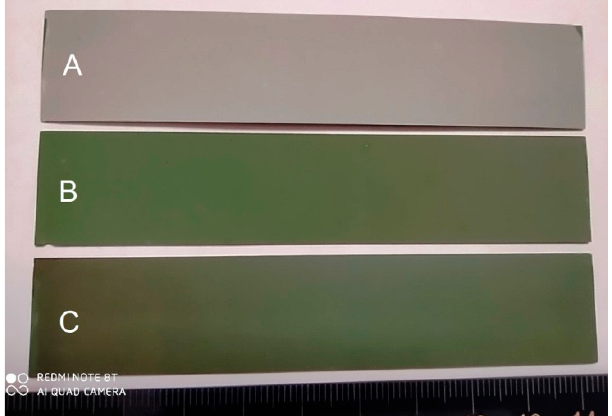
Figure 5. Photograph of YSZ electrolyte films (from Table 1) annealed at 1200 °C: A —film 3 , B —film 2 , C —film 1. After 1200 °C annealing in air, the residual stresses in the YSZ film fabricated in the oxide mode (film 1) reduce by 2 times and equal 947 MPa. The residual stresses reduce to 166 MPa in the YSZ film with small oxygen deficiency (film 2). This is probably associated